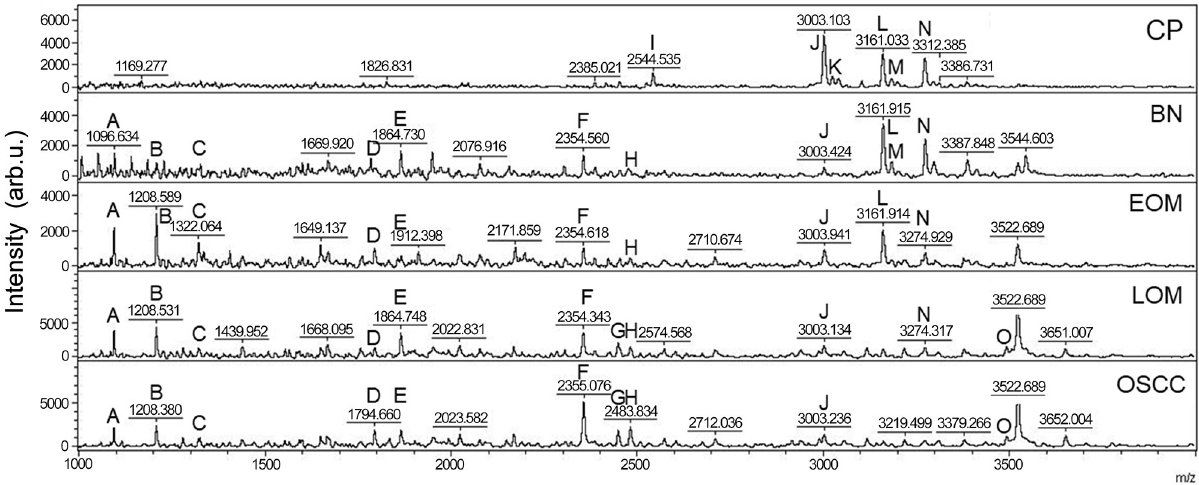
Fig 2. Peptide mass fingerprint (PMF) of normal and periodontitis gingiva tissues (CP), benign tumors (BN), early-stage oral melanoma (EOM), late-stage OM (LOM) and oral squamous cell carcinoma (OSCC) in the range 1000–5000 Da with identified proteins of each mass spectrum. A: SENP7 or KAT2B (1096 Da); B: PPRC1 or RMND1 (1208 Da); C: DTX3L (1322 Da); D: ZNF699) (1794 Da); E: MAP3K15 or ATP6V1E2 (1864 Da); F: PLCL2 (2354 Da); G: TNRC18 (2450 Da); H: COL12A1 (2483 Da); I: ZNF451 (2544 Da); J: protocadherin FAT1 (3003 Da); K: CASPL4A2 (3026 Da); L: centrosomal protein 192 (3161 Da); M: glypican 5 (3184 Da); N: cell-cycle checkpoint protein RAD17 (3274 Da); O: TLR4 (3492 Da). arb. u., arbitrary unit.